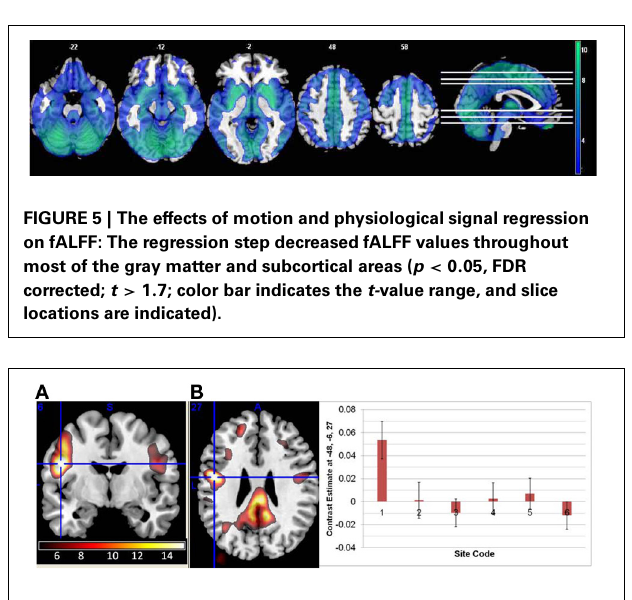
FIGURE 6 | The main effect of site in the fALFF analysis. (A) The effect of site in the original fALFF analyses, thresholded at F > 5 and overlaid on a template brain. Cross hair at the maximal voxel ( − 48, − 6, 27). (B) The contrast estimates across the different sites, with the first site being the 3T GE and the others being 3T Siemens scanners. Site 7 was the implicit